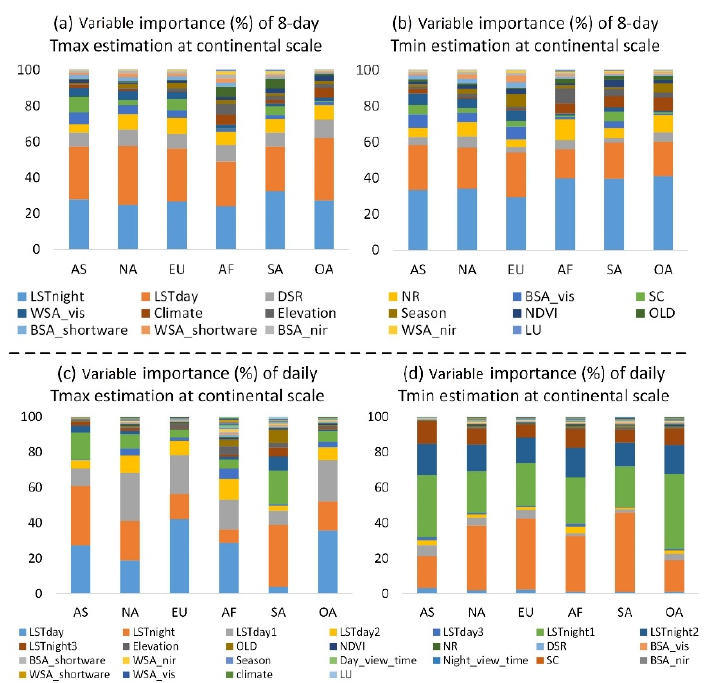
Figure 8. Variable importance (%) of 8-day tmax ( a ), 8-day Tmin ( b ), daily Tmax ( c ), and daily Tmin ( d ) estimation in spatial experiments at a continental scale.